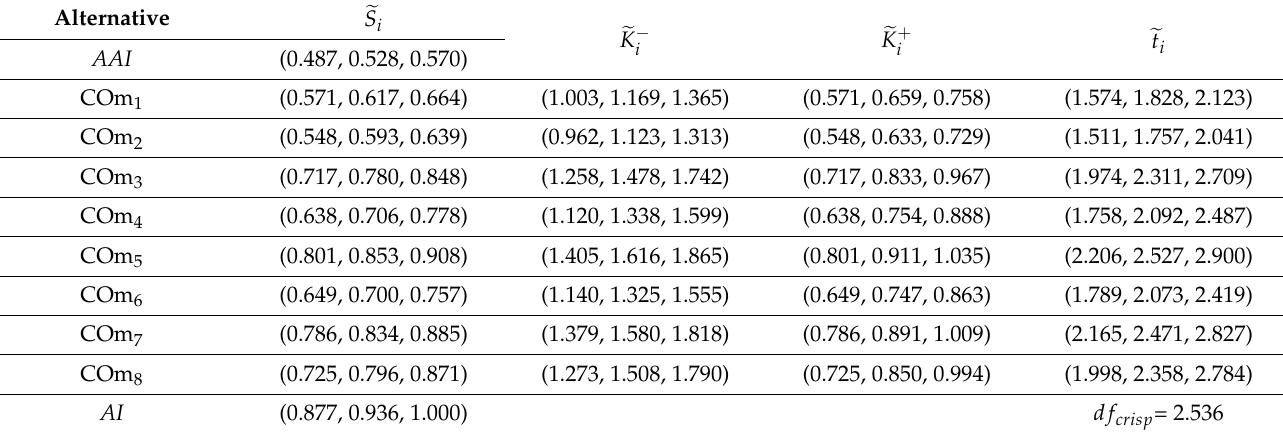
Table 5. Calculating and summarizing the utility degree and fuzzy matrix of (cid:101) t i